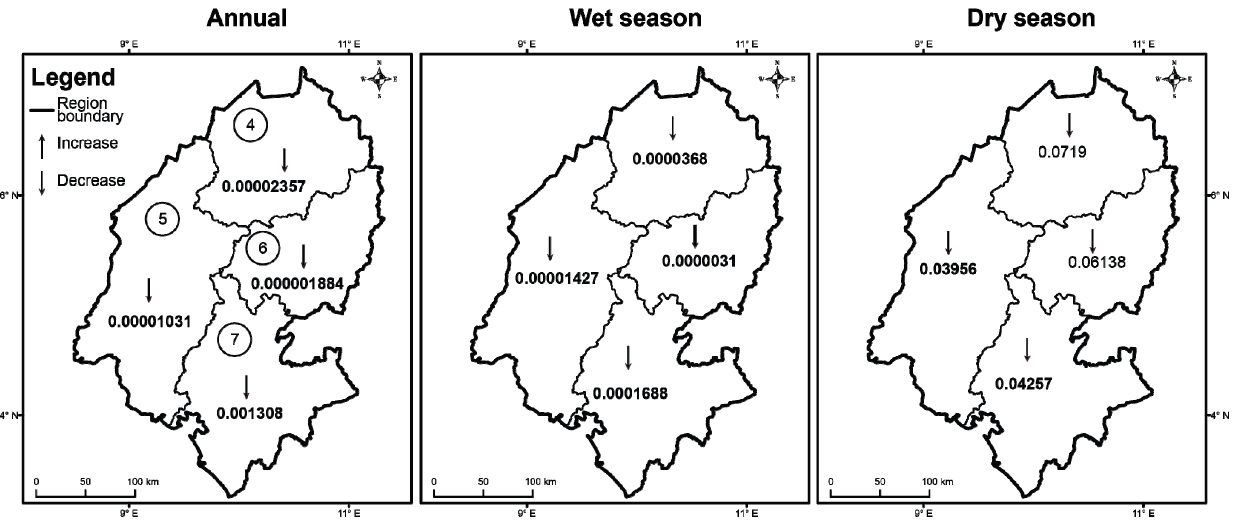
Figure 4. Results of annual and seasonal rainfall for the western regions of the country (Littoral (7), West (6), South-West (5), and North-West (4)), using Mann–Kendall’s test. There is a significant trend in the series when the calculated p -values are below the significance level ( α = 0.05). Significant trends are indicated by values in bold.